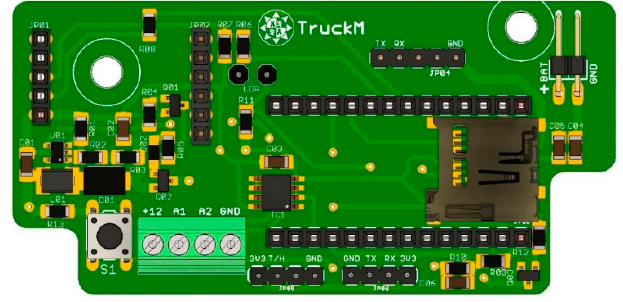
Figure 6. Gateway node 3D view of the PCB.